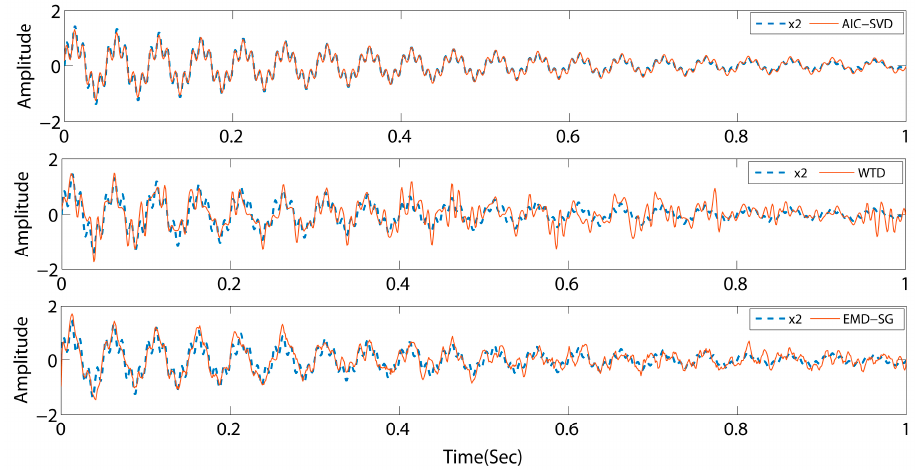
Figure 6. Comparison of denoising effects by different methods for signal s 2 .